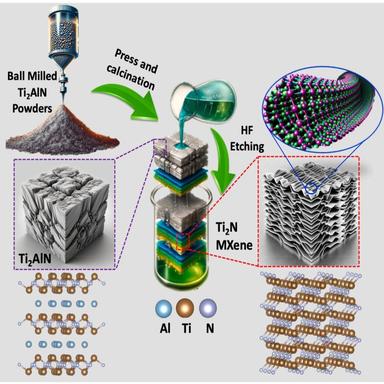
The preparation of Ti2AlN MAX and Ti2NTx MXene phases.